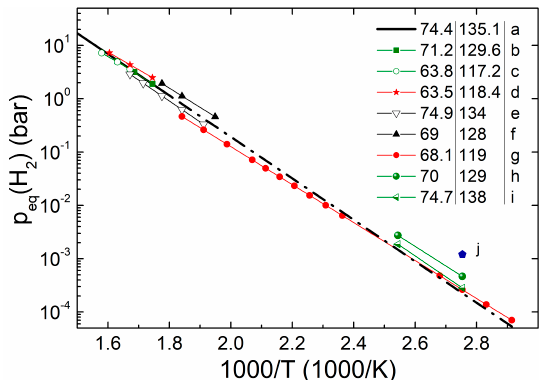
Figure 6. Compilation of van ‘t Hoff plots calculated from ∆ H 0 and ∆ S 0 data for Mg-based nanomaterials confronted to bulk Mg (curve a from Ref. [13]). The black dash-dotted line is the low temperature extrapolation of bulk Mg data. In the legend, the numbers in the columns denote the corresponding absolute values of ∆ H 0 (left, in kJ/mol H 2 ) and ∆ S 0 (right, in J/K mol H 2 ). The meaning of the colors is as follows: red for freestanding NPs; green for embedded or supported NPs; blue for thin films; black for ball-milled materials. The number of symbols represents the number of experimental points measured by the authors to determine enthalpy and entropy. b : 2–7 nm Mg nanocrystallites in LiCl matrix [14]. c : <3 nm Mg NPs in carbon scaffold [45]. d : 15 nm Mg NPs by electroless reduction [43]. e : MgH 2 -TiH 2 ball-milled nanocomposite (30 at.% Ti) [46]. f : MgH 2 -0.1TiH